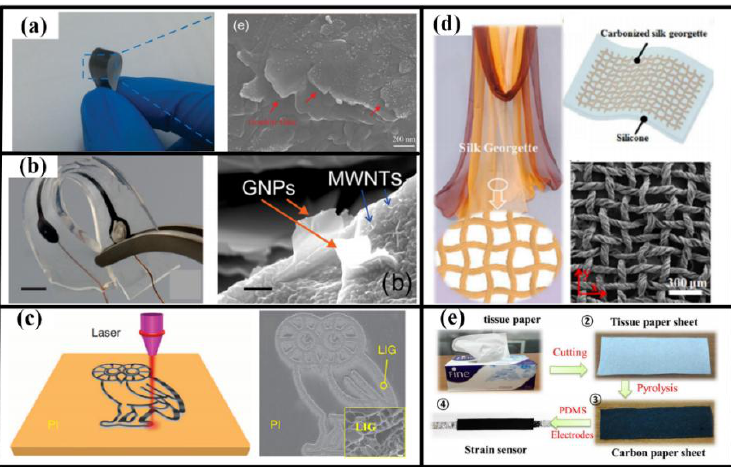
Figure 9. Carbon-based materials for sensing element: ( a ) graphene flakes from commercial pencil; ( b ) graphene flakes and MWCNTs compounded in substrate; ( c ) laser induced graphene on PI film; the carbonized silk georgette ( d ) and tissue paper ( e ). Reproduced from [139] with permission of WILEY. Reprinted from [138], with the permission of AIP Publishing. Adapted with permission from [149], Copyright (2014) Nature. Reproduced from [150] with permission of The Royal Society of Chemistry. Reprinted with permission from [152], Copyright (2016) American Chemical Society.